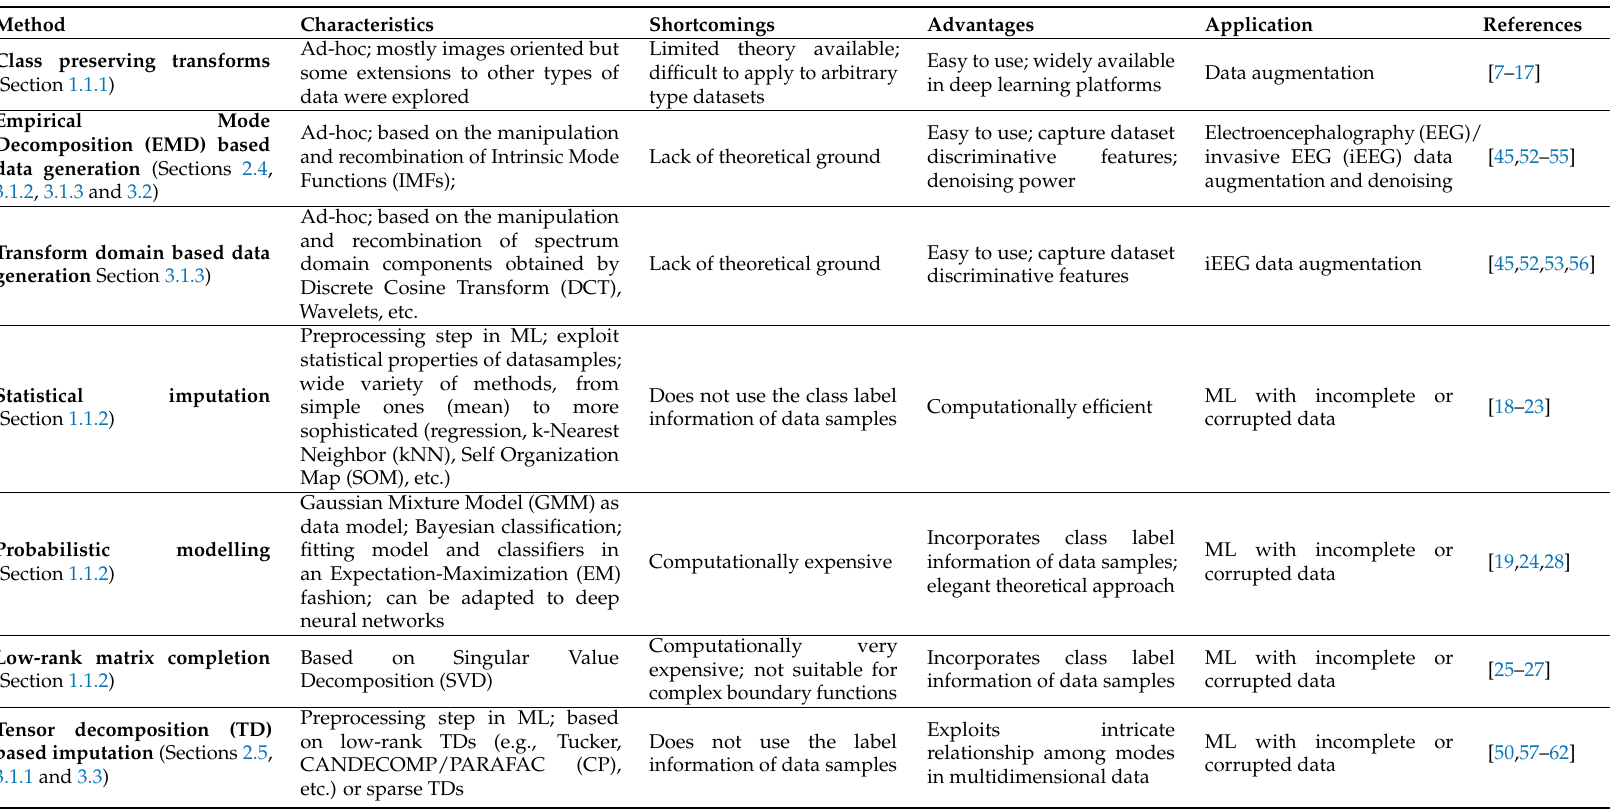
Table 1. Comparison of methods for Machine Learning (ML) problems with low-quality datasets. Article sections in which these methods are discussed are noted in the first column and relevant references are included in the last